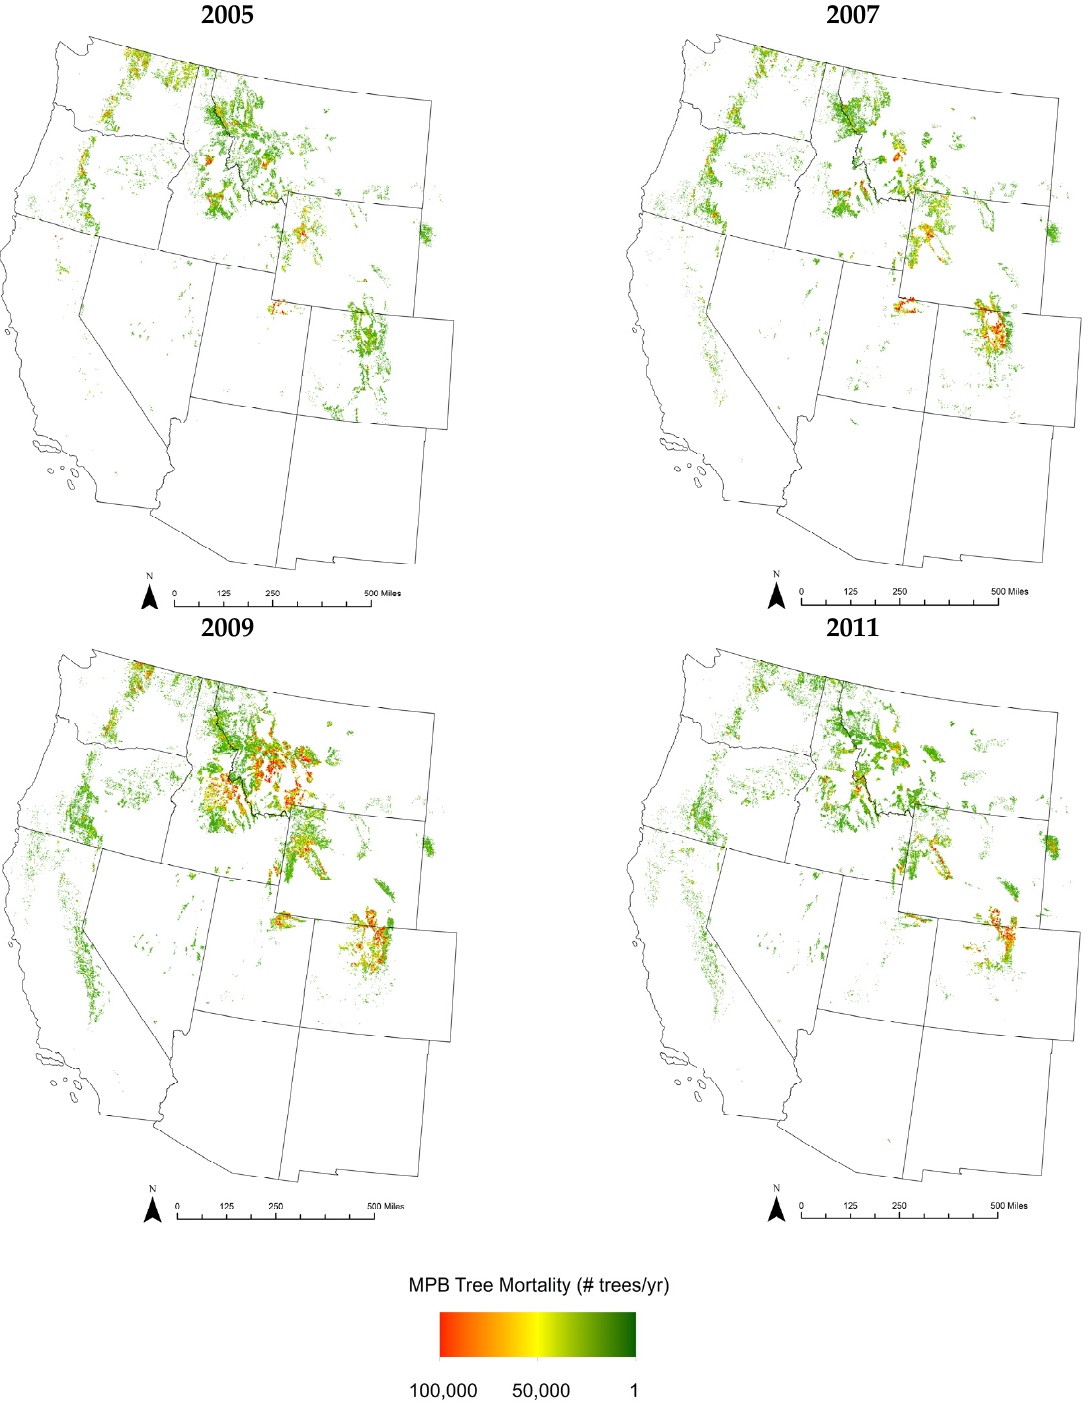
Figure 1. Western US MPB tree mortality across time. Constructed using the US Forest Service Insect and Disease Survey (IDS) database Digital Aerial Sketch Mapping (DASM) system for MPB. All conifer tree host species